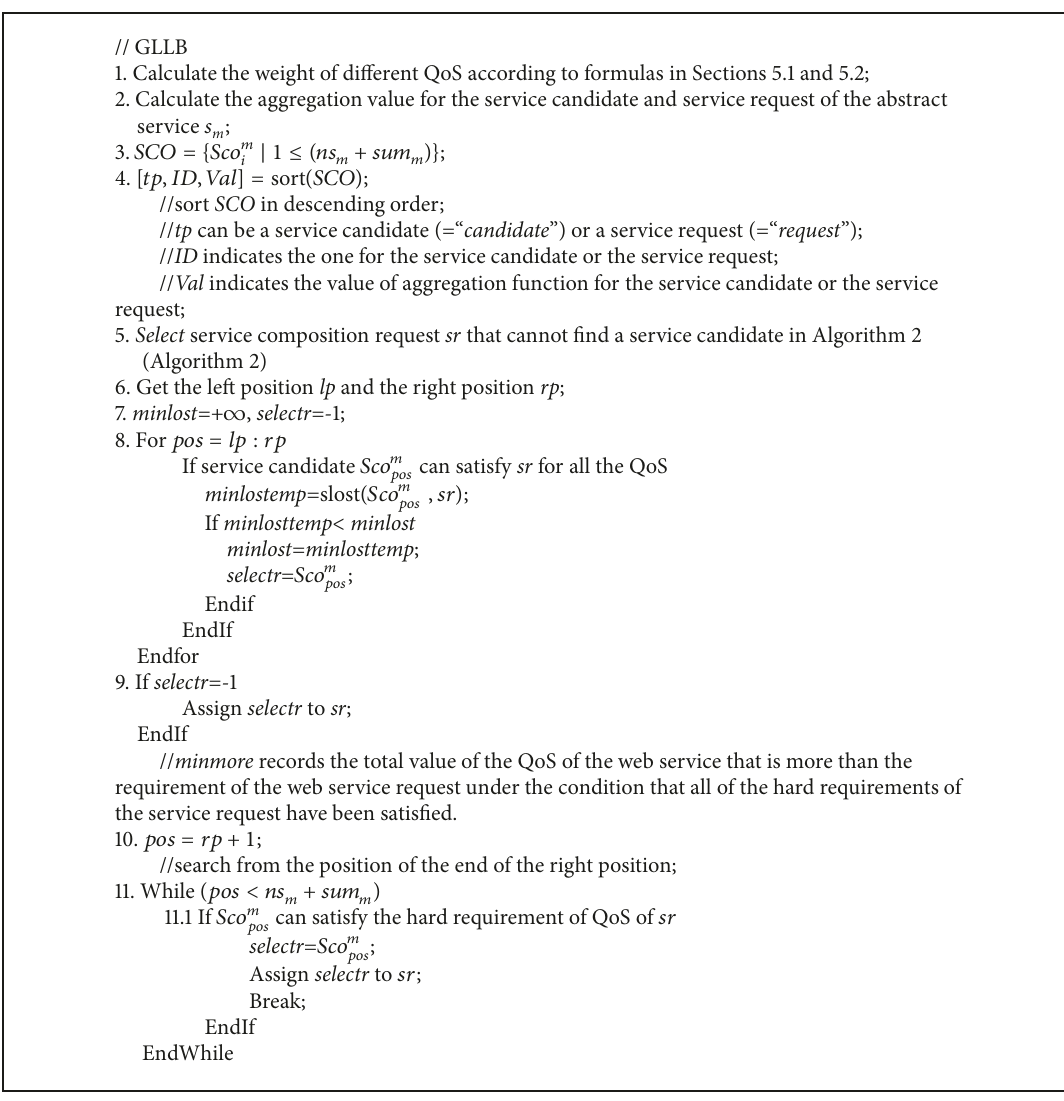
Algorithm 3: Schsoft (abstract service s